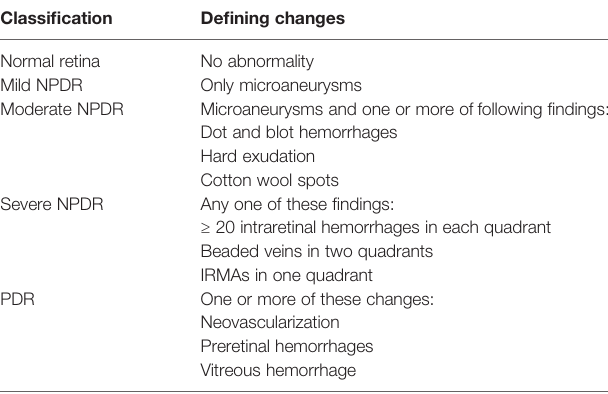
TABLE 1 | Classi fi cation of Diabetic Retinopathy. Classi fi cation